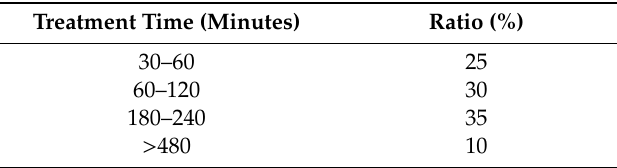
Table 2. The ratios of different treatment times for a patient.